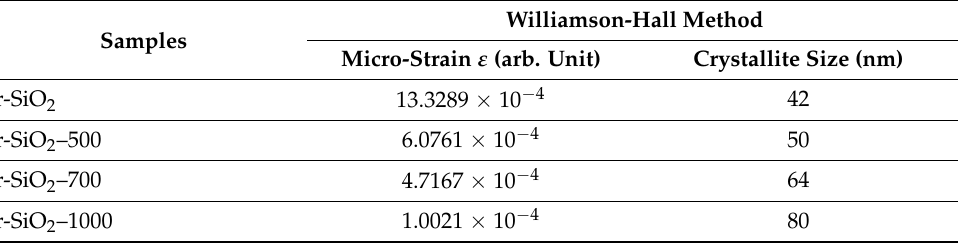
Table 3. Crystallite size and micro strain values obtained from the Williamson–Hall plot for flint samples as a function of the temperature treatment.